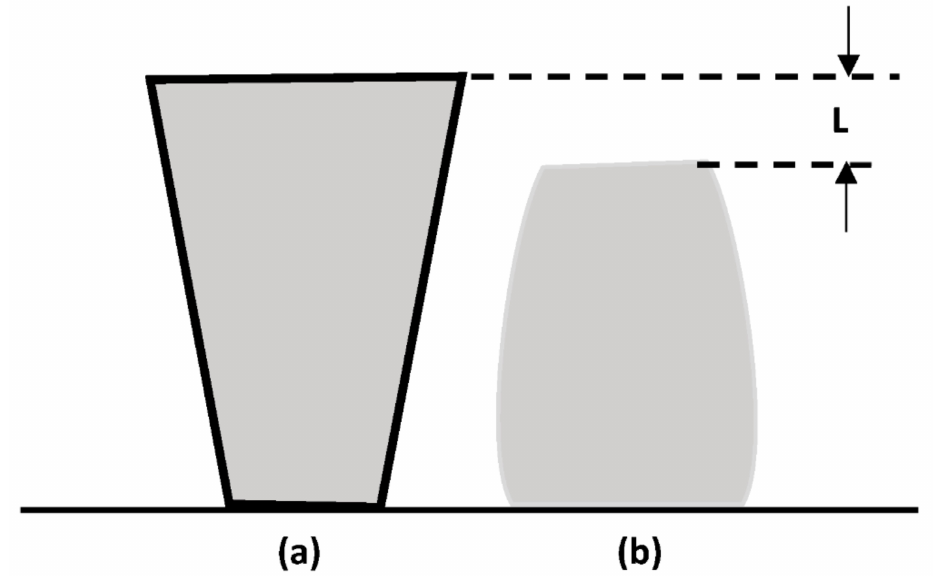
Figure 1. Schematic representation of the slump test: ( a ) Slump cone, ( b ) Concrete